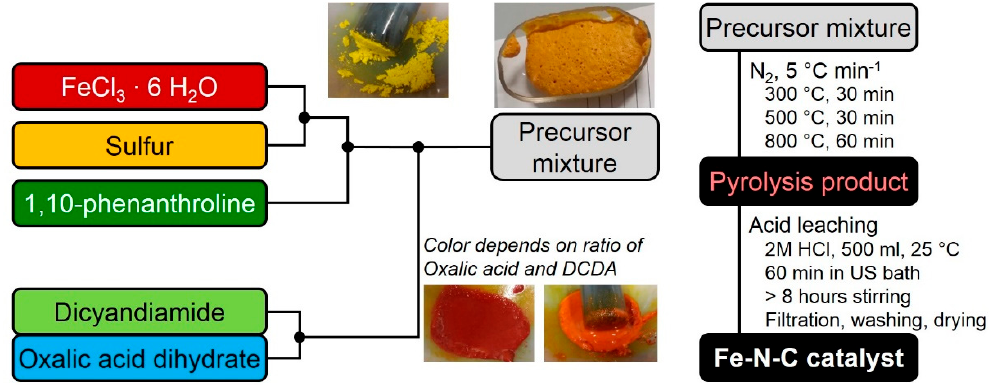
Figure 8. Scheme of the preparation procedure to obtain Fe-N-C catalysts by the use of two different type of SFA.